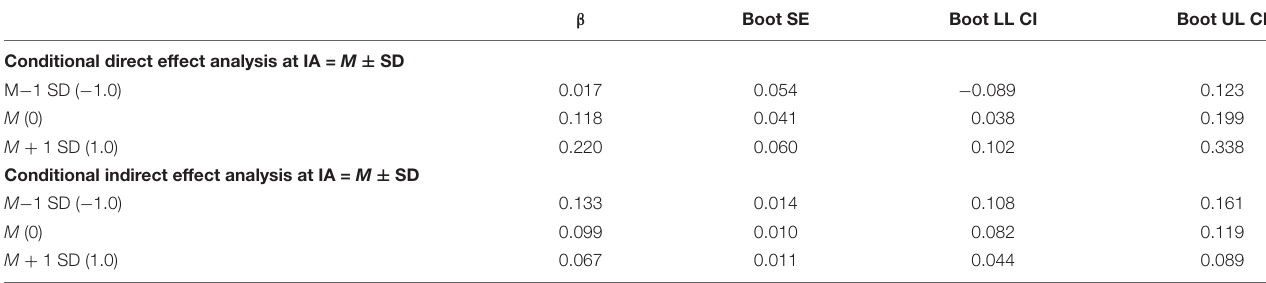
TABLE 5 | The direct and mediating effects on the different levels of socioeconomic